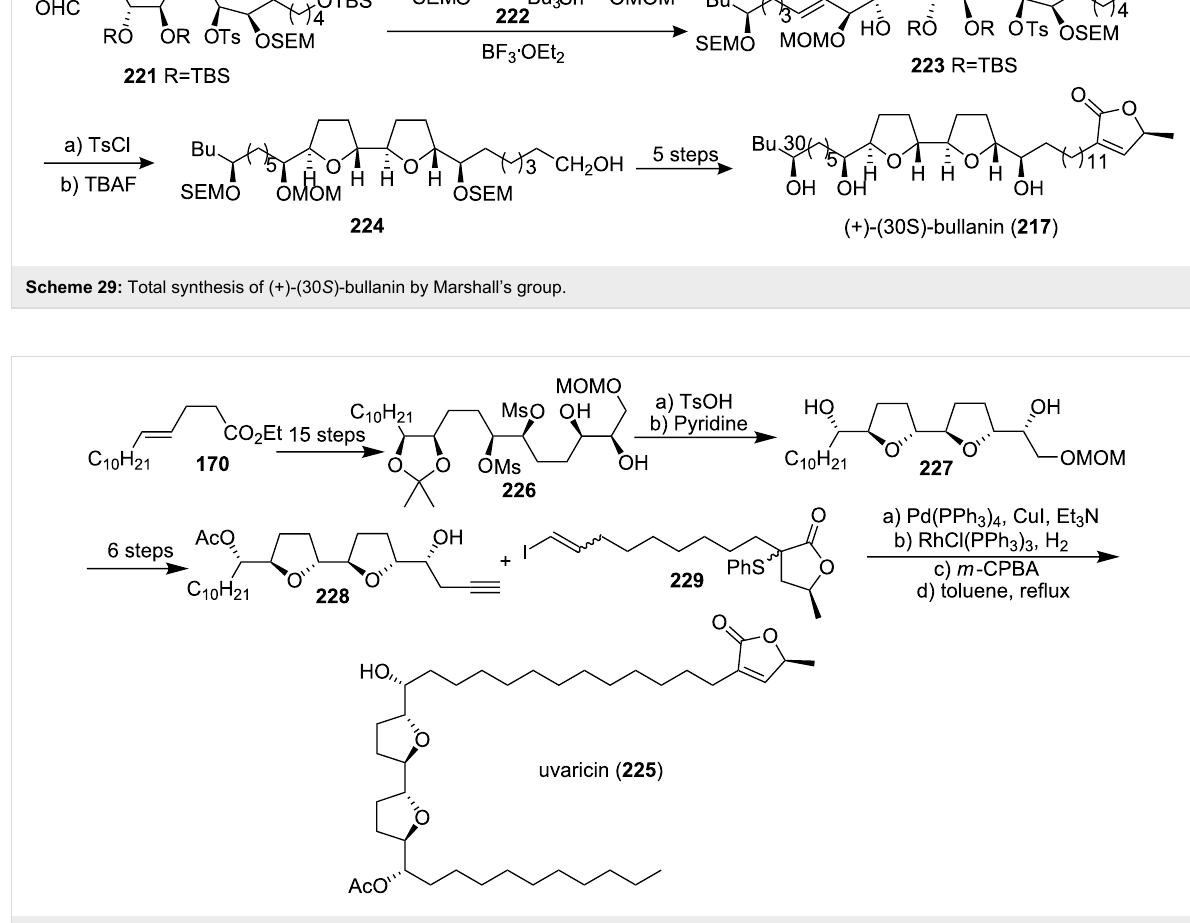
Scheme 30: Total synthesis of uvaricin by the group of Sinha and